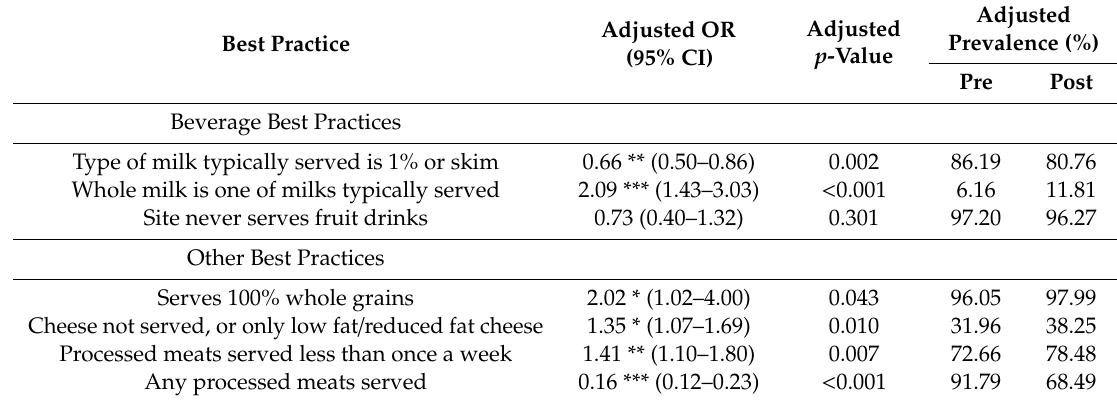
Table 3. Progress in meeting selected CACFP best practices,